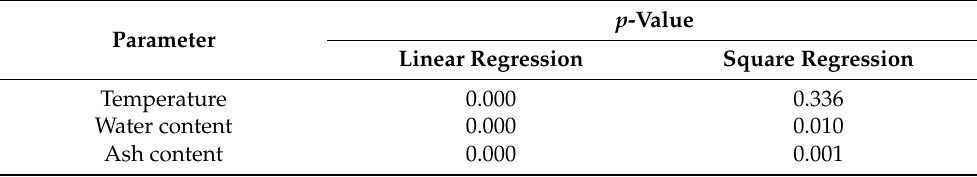
Table 5. Simultaneous regression coefficient test